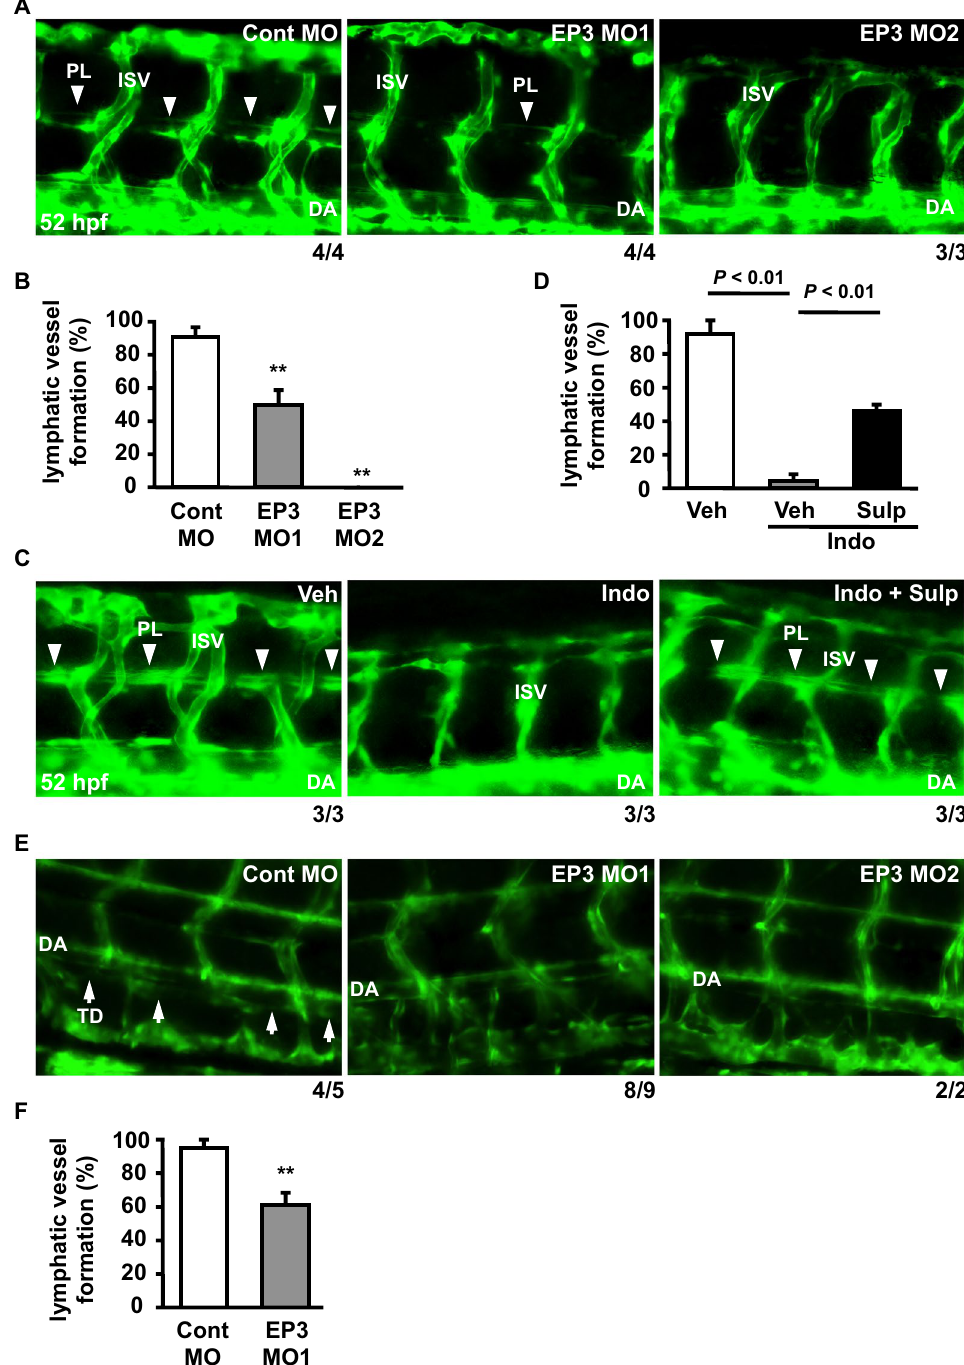
Figure 1. Role of the PGE 2 -EP3 pathway in lymphatic vessel formation. ( A ) Tg(fli1a:egfp) embryos were injected with Cont MO, EP3 MO1, or MO2. Images of the trunks were taken at 52 hpf. ( B ) The ratio of PL- positive segments in nine consecutive segments of ( A ) was quantitated. Each value represents the mean ± SEM (N = 3–4). ( C ) Tg(fli1a:egfp) embryos were treated with vehicle (Veh) or indomethacin (Indo; 100 μ M) in the absence or presence of sulprostone (Sulp; 1 μ M) from 0 to 52 hpf. Images were taken at 52 hpf. ( D ) The ratio of PL-positive segments in nine consecutive segments of ( C ) was quantitated. Each value represents the mean ± SEM (N = 3). ( E ) Tg(fli1a:egfp) embryos were injected with Cont MO, EP3 MO1, or EP3 MO2. Images of the trunks were taken at 5 dpf. ( F ) The ratio of TD-positive segments in eight consecutive segments of Cont MO- or EP3 MO1-injected morphants was quantitated. Each value represents the mean ± SEM (N = 5–9). ** P < 0.01 vs Cont MO. DA: dorsal aorta; ISV: intersomitic vessel; PL: parachordal lymphangioblast; TD: thoracic duct. The PL is indicated by arrowheads, and the TD is indicated by arrows. The number at the bottom right of each panel indicates the number of embryos demonstrating the phenotype shown in the panel over the total number of embryos analyzed in a representative